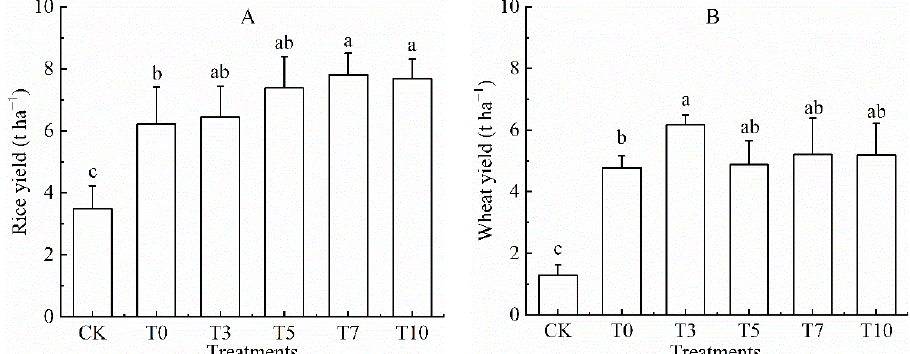
Figure 1. Effect of different fertilization treatments on the yield of rice ( A ) and wheat ( B ). Columns with different small case letters show significant difference between different treatments at p < 0.05 by LSD’s multiple range test. Values are mean of four replicates and bars show standard deviation. CK, no nitrogen fertilizer applied; T0, 100% conventional urea (CU); T3, one-time basal application of slow-release urea (SRU) and CU mixture with 30% SRU; T5, one-time basal application of SRU and CU mixture with 50% SRU; T7, one-time basal application of SRU and CU mixture with 70% SRU; T10, one-time basal application of 100% SRU.